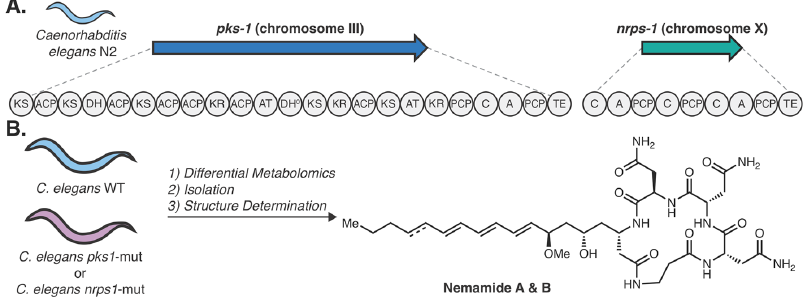
Figure 7. Nemamide biosynthesis in Caenorhabditis elegans . ( A ) Domain architecture of the Caenorhabditis elegans N2 PKS ( pks ‐ 1 ) on chromosome III and the NRPS ( nrps ‐ 1 ) on chromosome X. ( B ) Differential metabolomics approach using both pks ‐ 1 and nrps ‐ 1 mutated worms against WT worms to identify the nemamide metabolites, which were subsequently isolated and